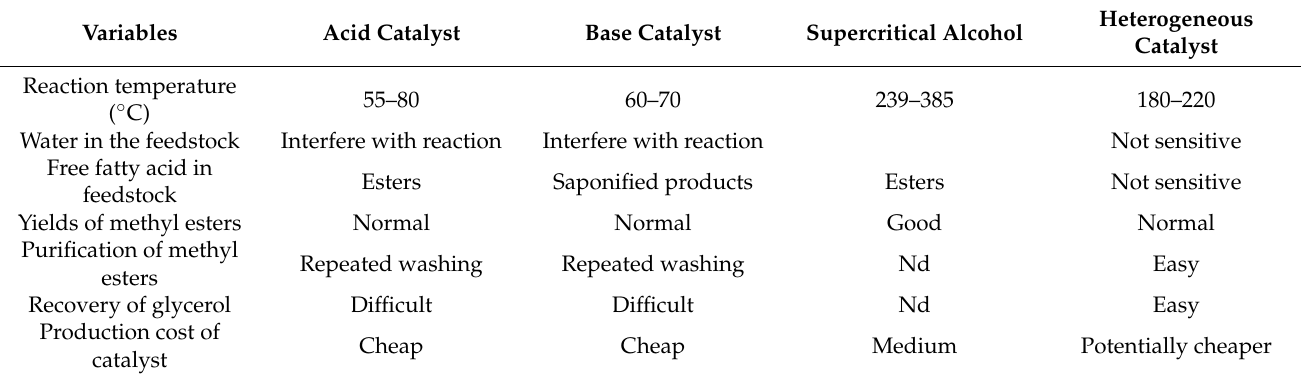
Table 4. Comparison of different technologies in producing biodiesel. Modified from